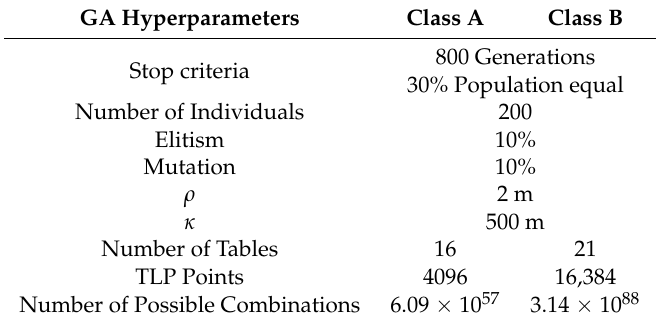
Table 2. GA hyperparameters used for all simulations, the hyperparameter values were optimized and adjusted experimentally. Elitism and Mutation values are provisional and require further adjustment.